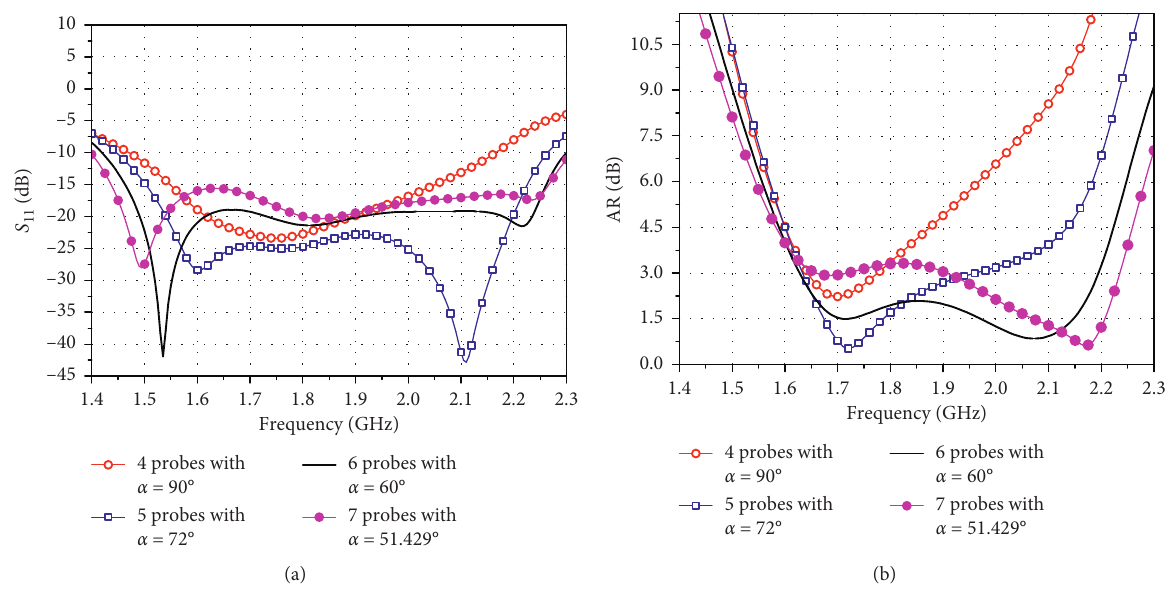
Figure 4: Effects of the number of probes on (a) S